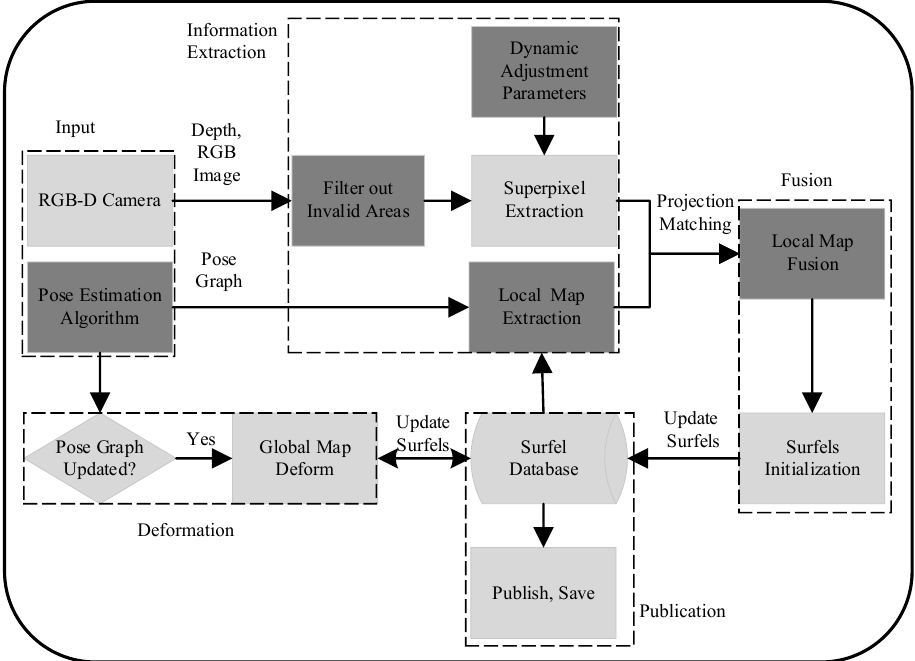
Figure 1. System framework. The system is mainly divided into five parts, as shown by the dot- ted